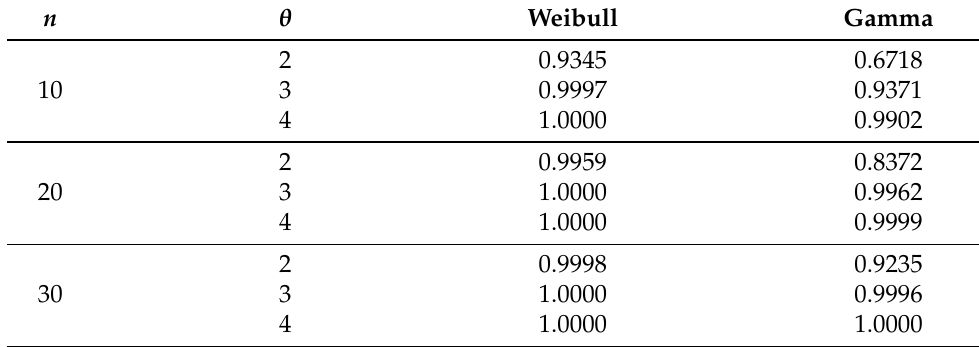
Table 3. The power estimates of ˆ ∆ ( 0.99 )